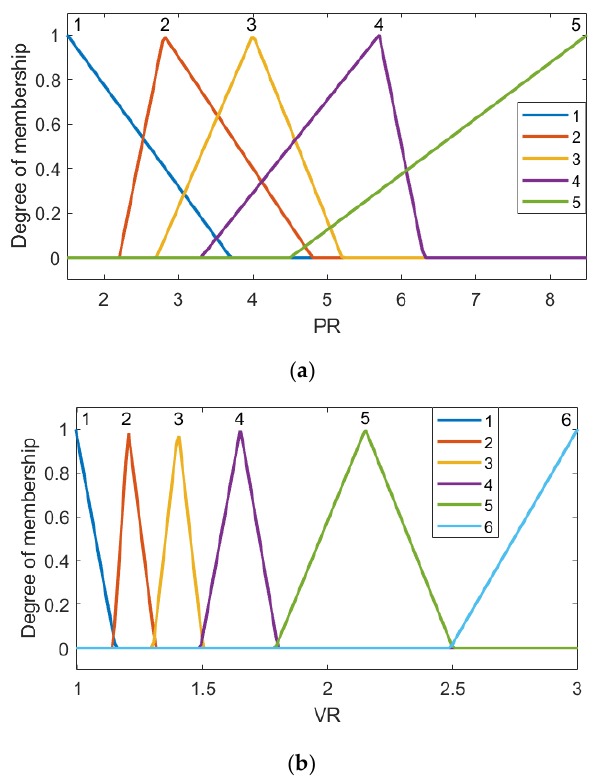
Figure 9. Membership functions of the minor fault model: ( a ) power rate, ( b ) voltage rate.